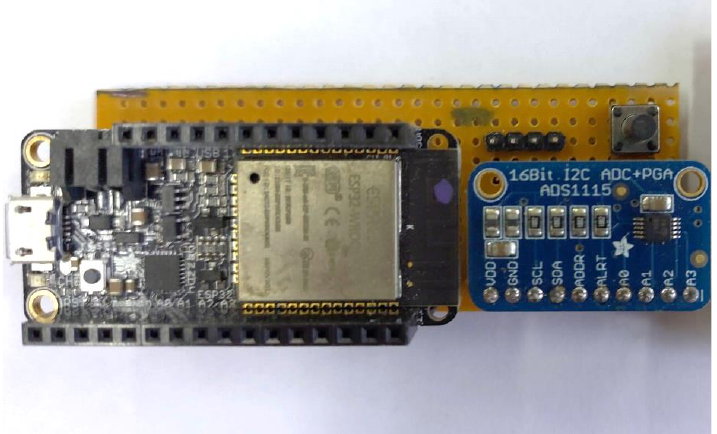
Figure 11. The electronics board, including the microcontroller’s board and the external ADC.